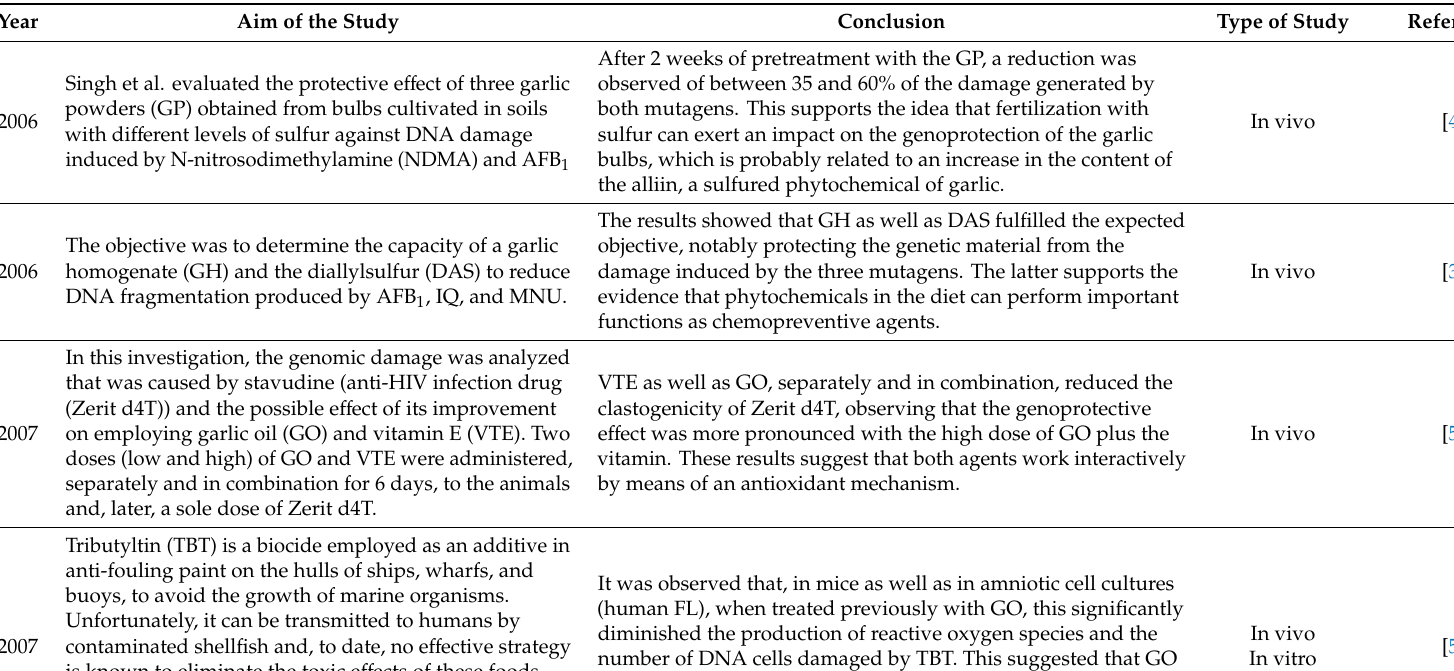
Table 3. Studies carried out with the comet assay (CA) that evaluate the antigenotoxic e ff ect of